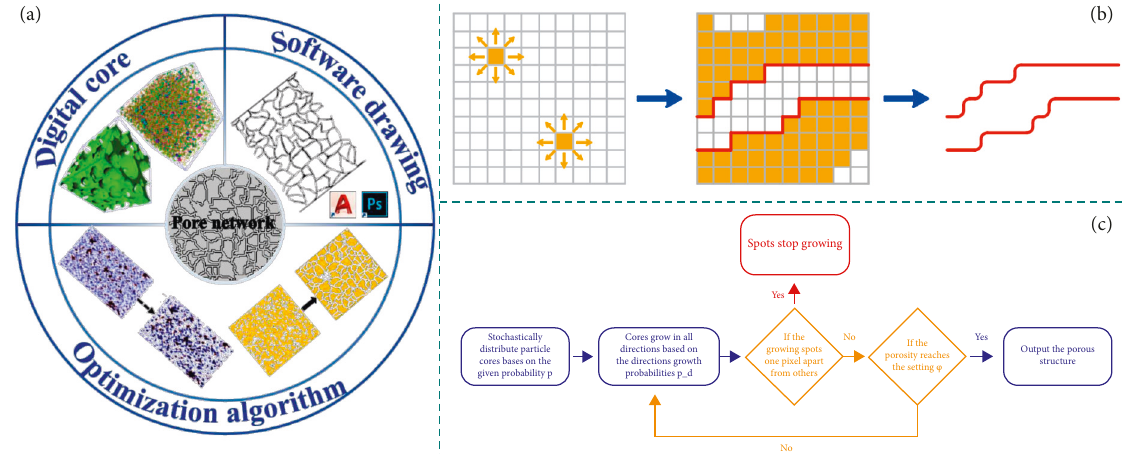
Figure 2: Random pore generation methods and the improved QSGS algorithm adopted in this